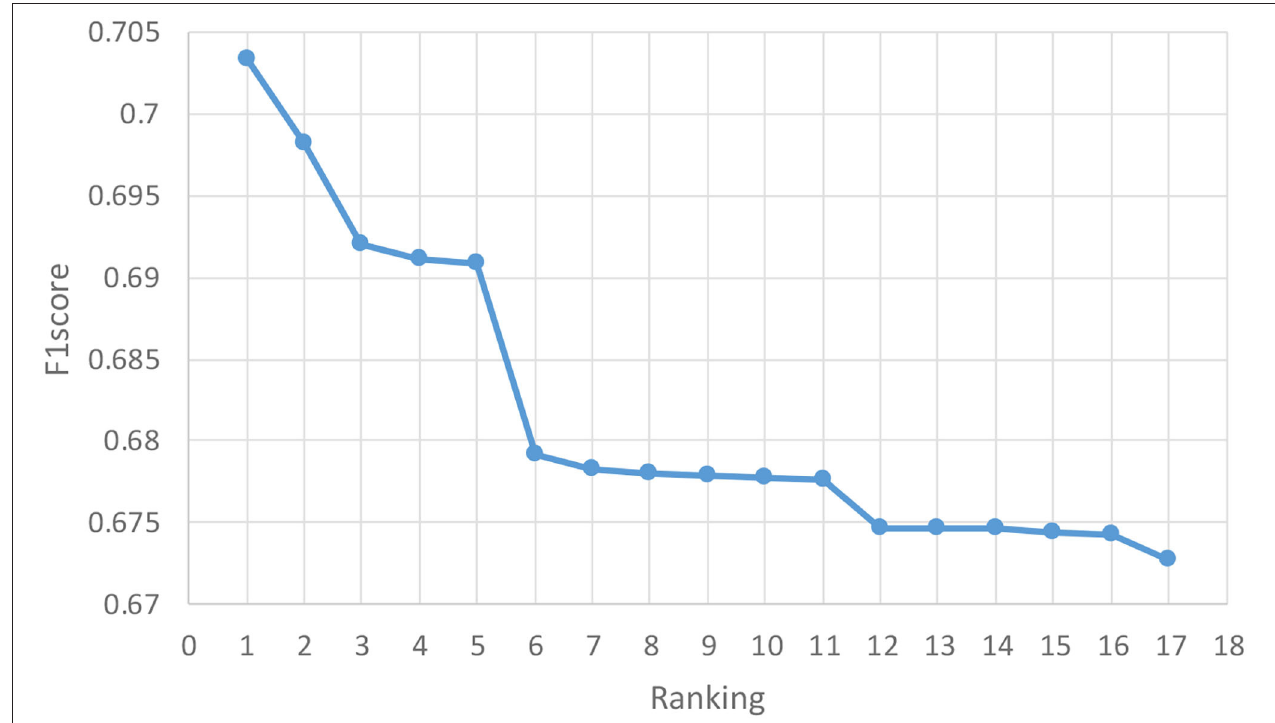
FIGURE 5 | Results of the competition. The horizontal axis represents the ranking of the competition and the vertical axis represents the score of the competition. The competition uses F1score as the final evaluation metric. The figure shows the 17 winning teams among 373 teams, among which our team gained the rank of 10 th .